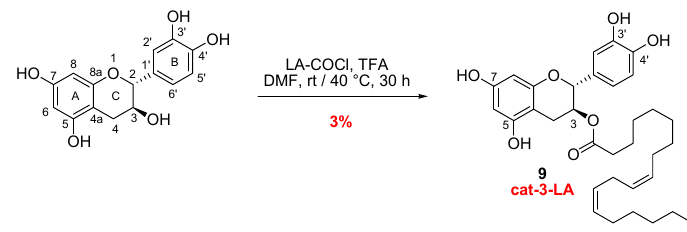
Figure 3. Synthetic pathway to access catechin-3-LA.